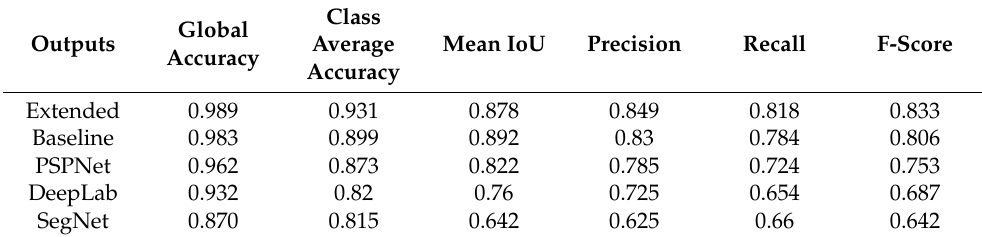
Table 3. The statistics for the used threshold segmentation